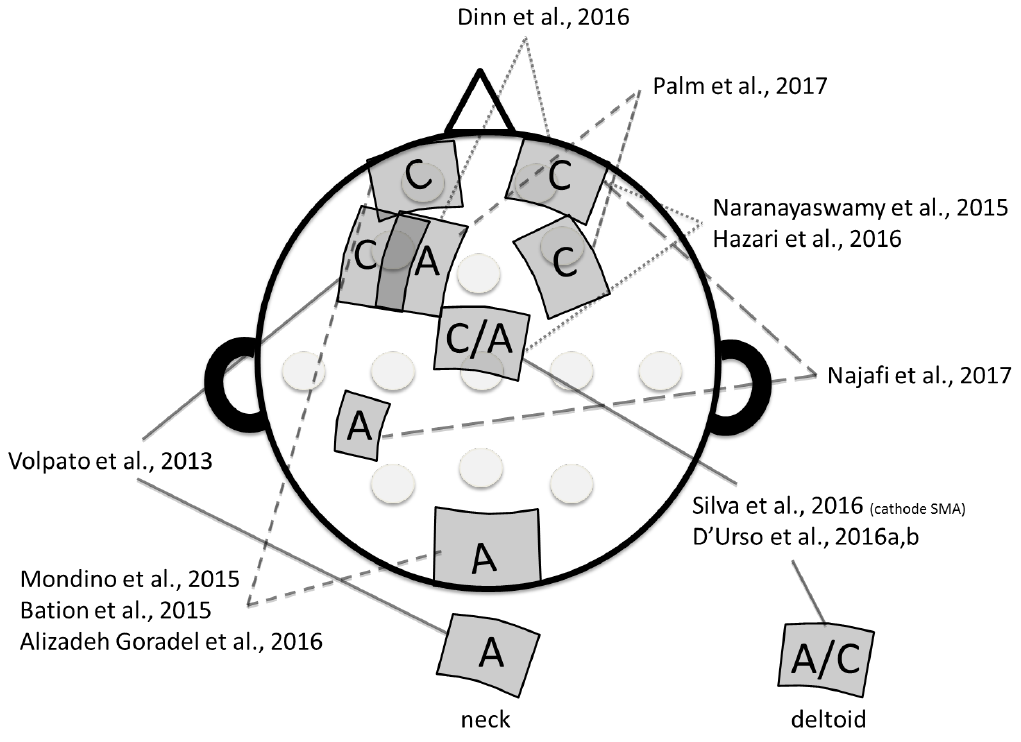
Figure 2. Illustration of the diversity in electrodes montage observed in transcranial direct current stimulation (tDCS) studies aiming to alleviate obsessive-compulsive symptoms in patients with treatment-resistant obsessive-compulsive disorder. A: Anode; C: Cathode. Hazari et al., 2016 [17]; Dinn et al., 2016 [18]; Alizadeh Goradel et al., 2016 [19]; Volpato et al., 2013 [20]; Narayanaswamy et al., 2015 [21]; Mondino et al., 2015 [22]; D’Urso et al., 2016a [23]; Silva et al., 2016 [24]; Palm et al., 2017 [25]; Bation et al., 2015 [26]; Najafi et al., 2017 [27]; D’Urso et al., 2016b [28].